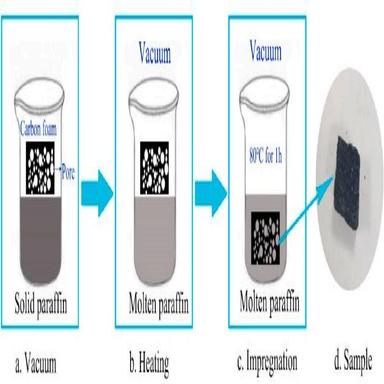
Schematic diagram of vacuum impregnation treatment for preparing composites.